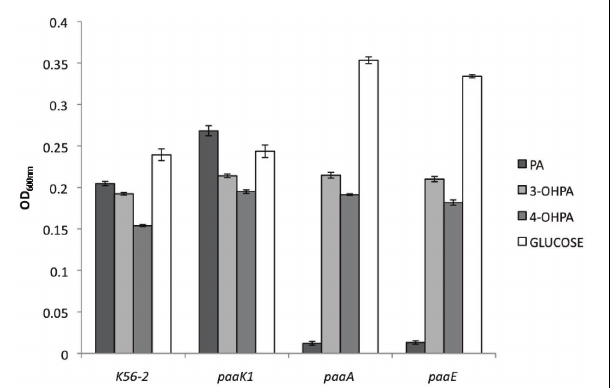
FIGURE 2 | Growth of B. cenocepacia strains with 3-OHPA, 4-OHPA as sole carbon sources. B. cenocepacia K56-2 (wild type), deletion